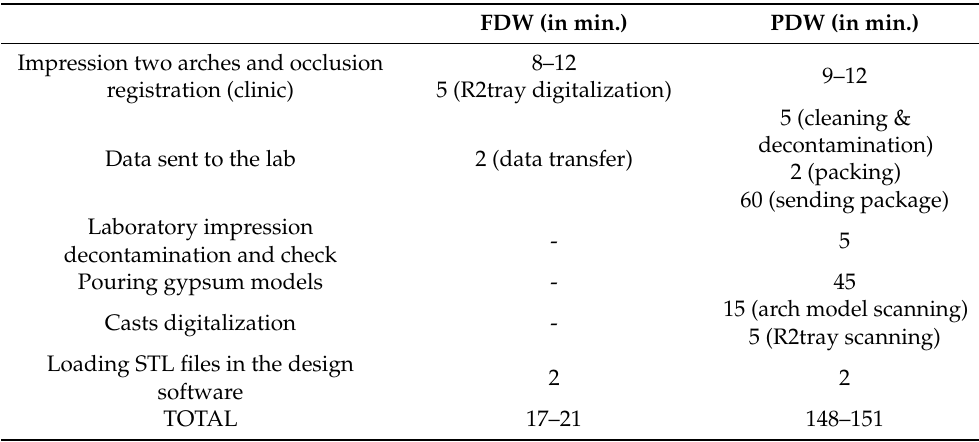
Table 5. Labor time for data collection and